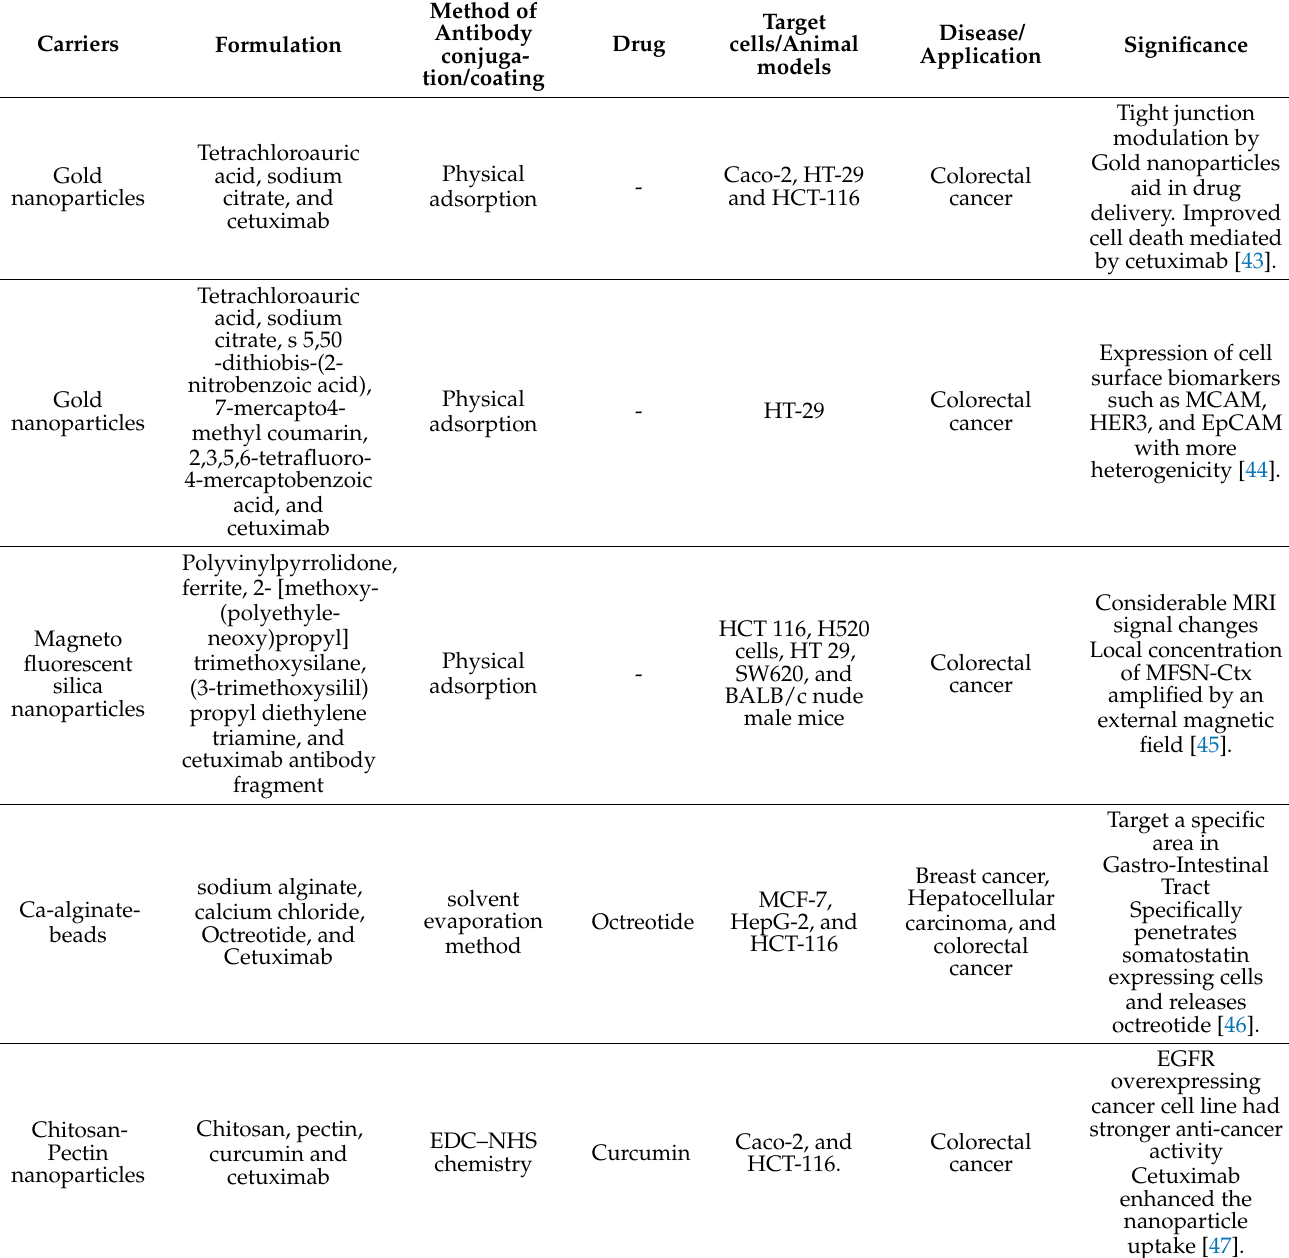
Table 2. List of Cetuximab conjugated carriers and their